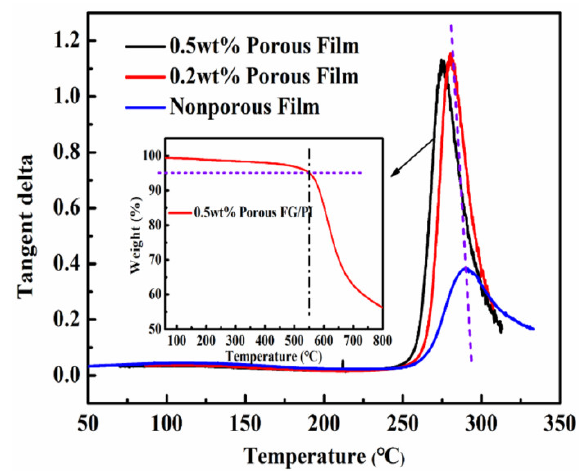
Figure 8. Thermal properties of PI films.